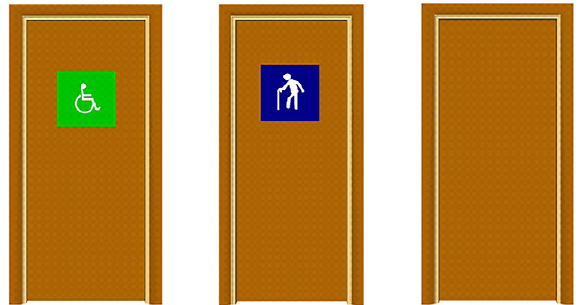
Figure 11. Example of accessible, ambulant, and normal doors